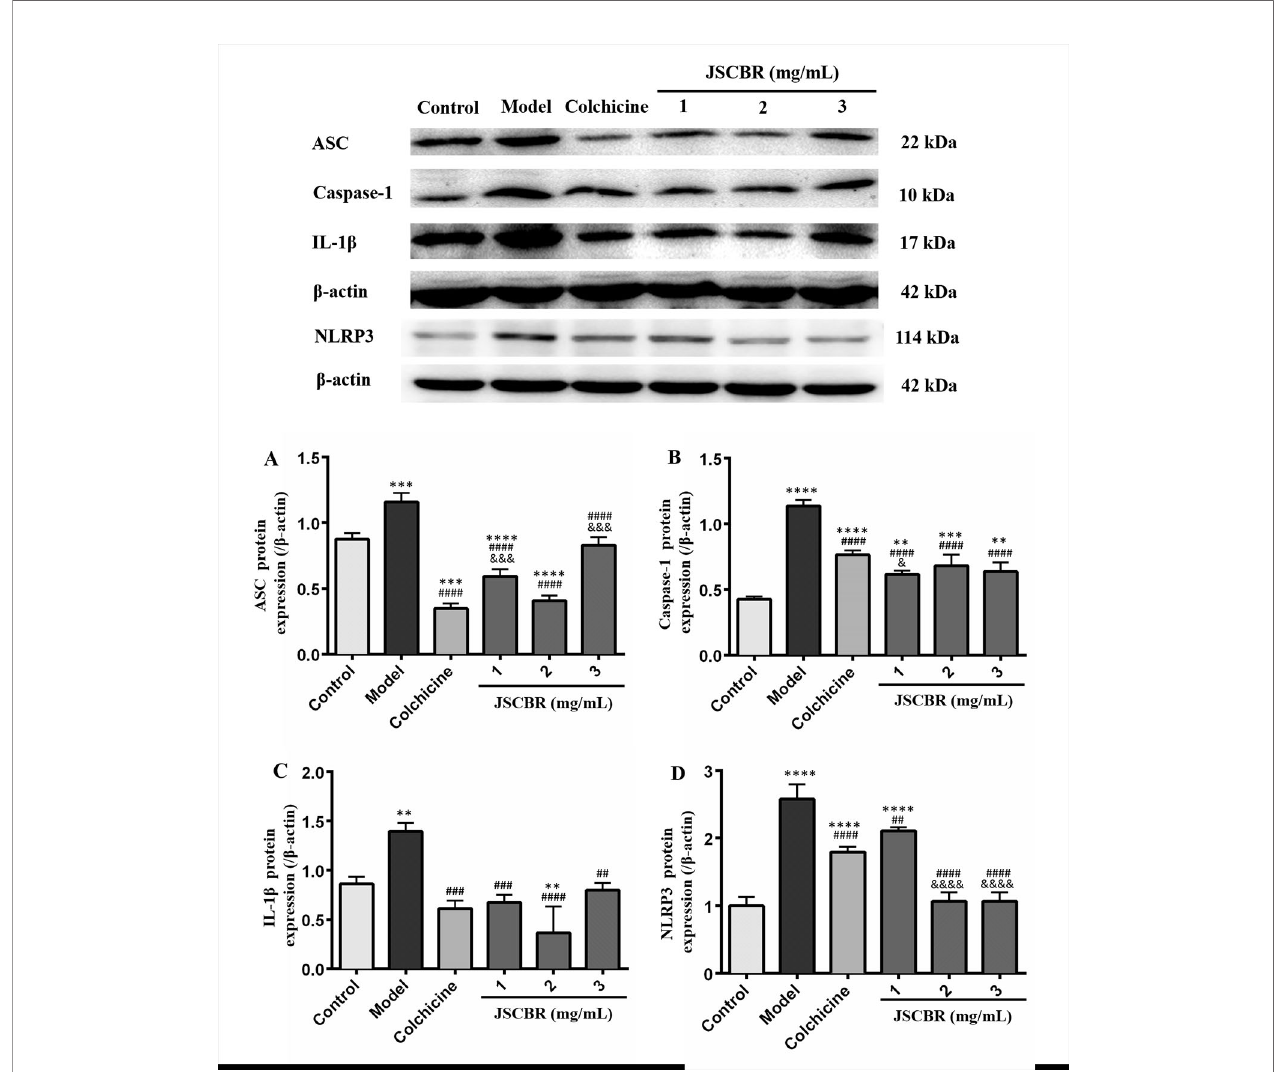
FIGURE 7 | Jiang-Suan-Chu-Bi recipe (JSCBR) extracts protect THP-1 cells against monosodium urate (MSU)-induced in fl ammation by affecting the expression of proteins from the NOD-like receptor signaling pathway. (A) Effects of JSCBR extracts on ASC, caspase-1, IL-1 b , and NLRP3 protein levels in MSU-induced THP-1 cells based on the western blotting assay; (B) Statistical analysis of the effects of JSCBR extracts on protein expressions levels. Data are presented as the mean ± SD ( n = 3), ** p < 0.01, *** p < 0.001, **** p < 0.0001 versus control group. ## p < 0.01, ### p < 0.001, #### p < 0.0001 versus model group. & p < 0.05, &&& p < 0.001, &&&& p < 0.0001 versus colchicine